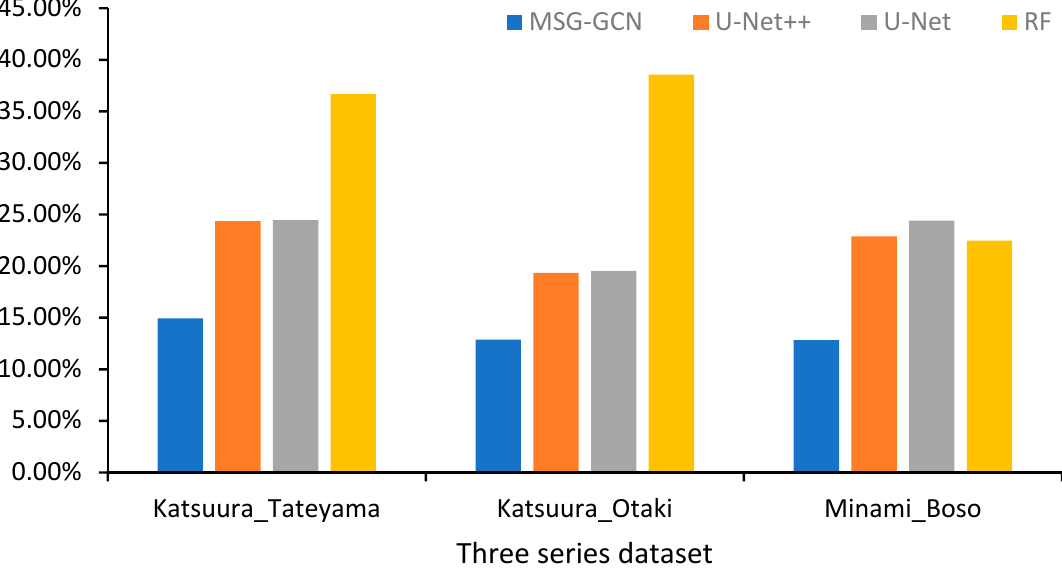
Figure 9. Misclassification rates for the different districts of all